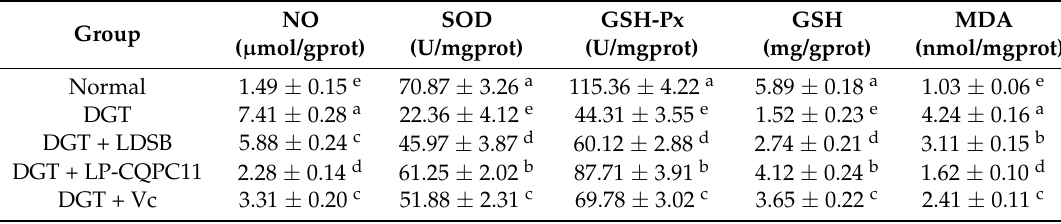
Table 4. The levels of NO, SOD, GSH-Px, GSH, and MDA in spleen of mice ( n = 10). NO SOD Group ( µ mol/gprot)